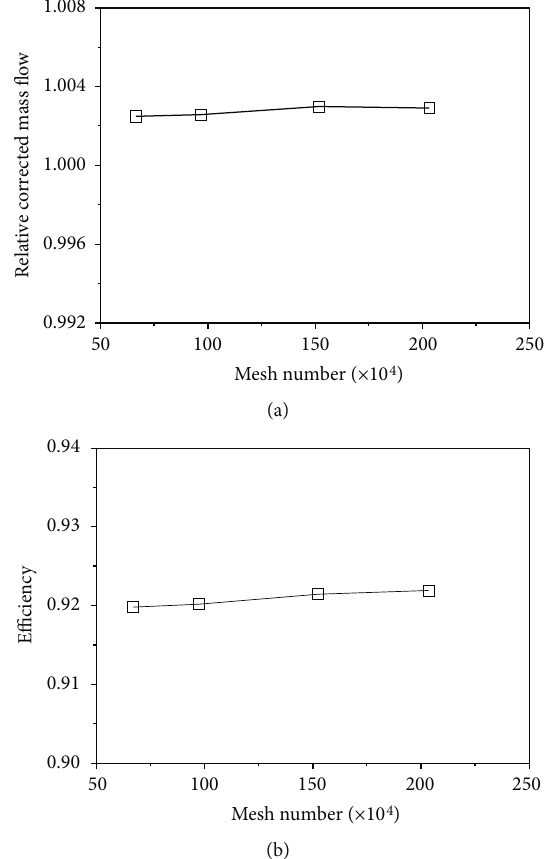
Figure 7: Grid-independence veri fi